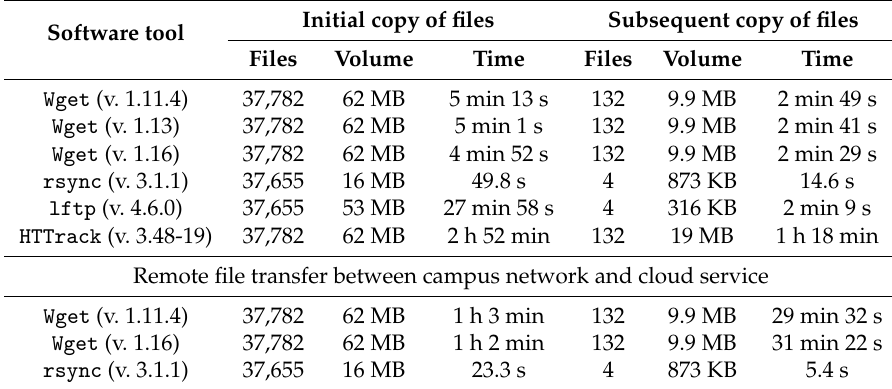
Table 6. Experimental results for different file transfer/synchronization